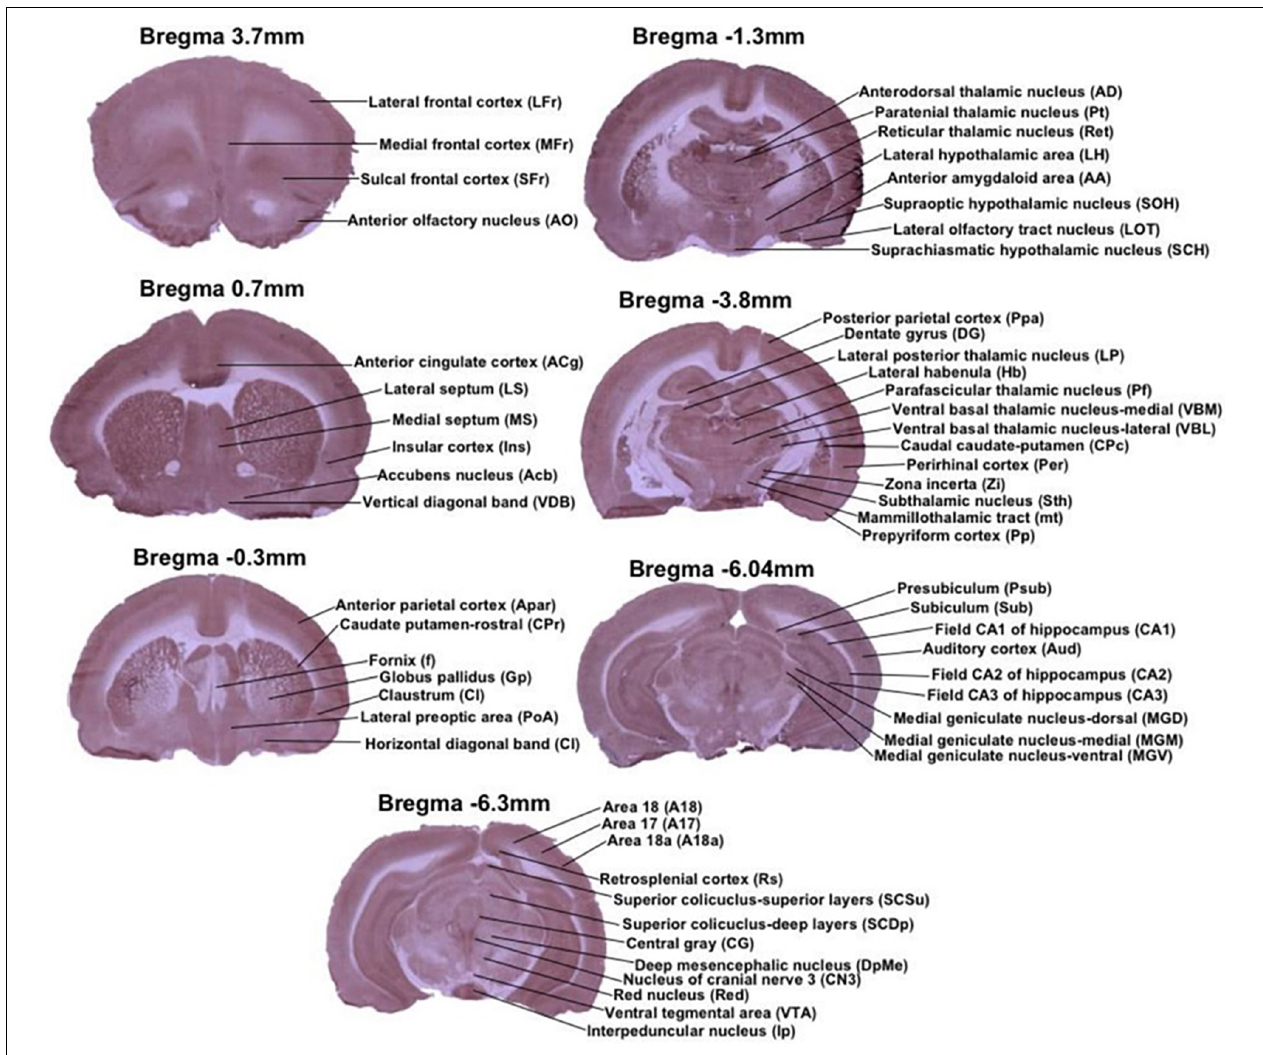
FIGURE 2 | Regions of interest from representative stained sections used in this study. Each image is a coronal brain section histochemically stained for cytochrome oxidase activity and depicting regions of interest by Bregma level. Anterior–posterior Bregma coordinates are indicated on top of each image. All of the stained sections in figure are CCO-stained sections, that are presented as exemplars of the CCO-stained sections analyzed in this study.